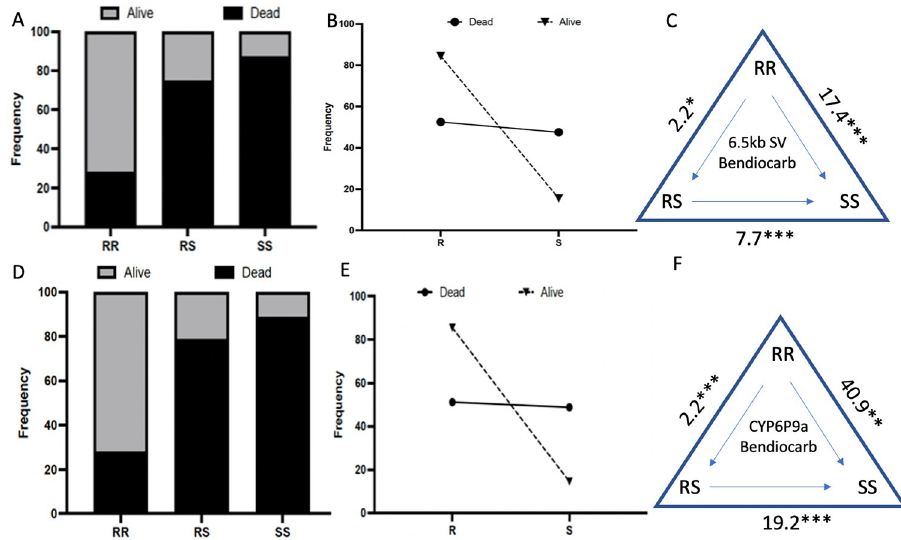
Fig 4. Correlation between genotypes at CYP6P9a/6 . 5kb SV and carbamate resistance. (A) Distribution of CYP6P9b genotypes between dead and alive An . funestus after exposure to 0.1% bendiocarb using WHO bioassay showing that CYP6P9a_R significantly allows An . funestus to survive exposure to this carbamate. (B) Correlation between frequency of CYP6P9b-R and ability to survive exposure to bendiocarb. C) Estimation of odds ratio (OR) and associated significance between different genotypes and the ability to survive exposure to bendiocarb. Ors are given with asterisks indicating level of significance. The arrow within the triangle indicates the direction of OR estimation. For example, Individuals that are RR are 17.4 times more likely to survive exposure to bendiocarb that those carrying two copies of the susceptible allele (SS). D), E) and F) are the same respectively for CYP6P9a